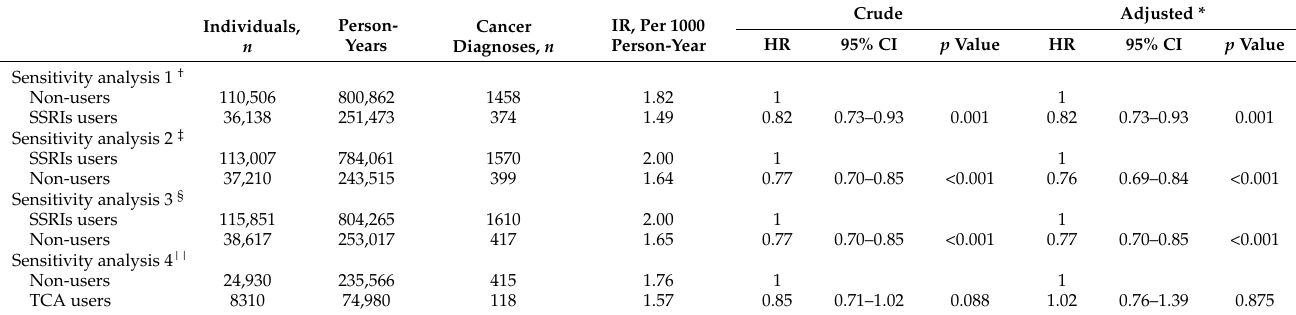
analysis 1: Use of SSRIs and the risk of CRC among individuals with a family history of CRC lagging one year after the first administration of SSRIs. ‡ Sensitivity analysis 2: Use of SSRIs and the risk of CRC among individuals with a family history of CRC after excluding individuals with a benign colorectal tumor. § Sensitivity analysis 3: Use of SSRIs and the risk of CRC among individuals with a family history of CRC. Both death and diagnosis of other cancers were modeled as competing events. || Sensitivity analysis 4: Use of TCA and the risk of CRC among individuals with a family history of